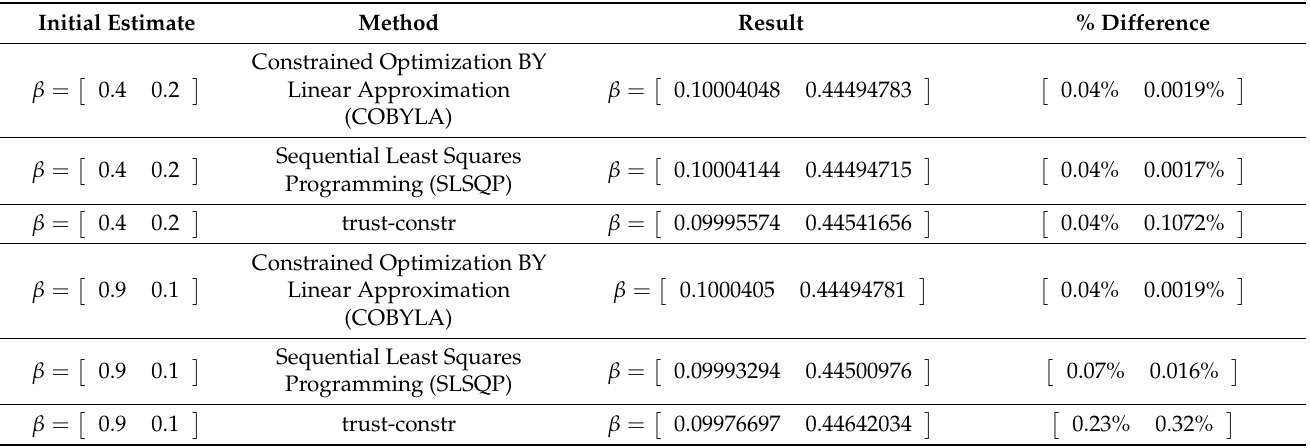
Table 1. Results for water/PASN system using different methods for the minimize function of Scipy-Optimize package for Python.